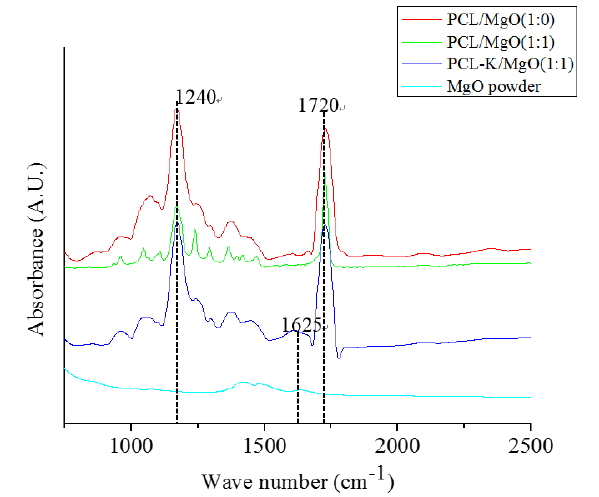
Figure 3. Comparative FTIR spectra of electrospun PCL/MgO and PCL-keratin/MgO nanofibers along with as-received MgO powder.